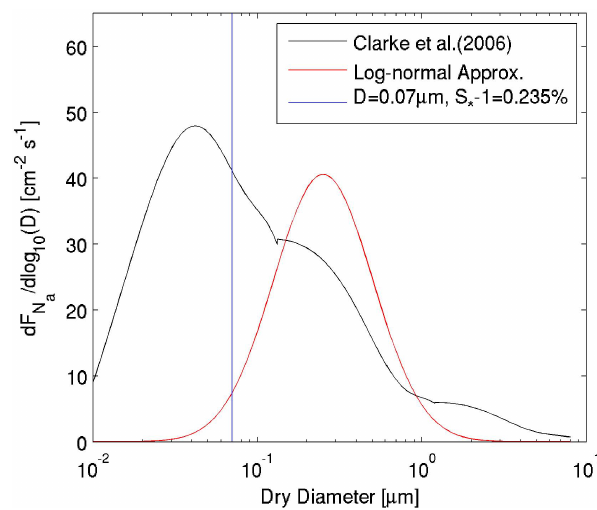
Fig. 2. Clarke et al. (2006) size-resolved sea-salt aerosol number flux and unimodal CCN approximation used in this study, plotted for u 10 of 9ms − 1 . Blue vertical line indicates cutoff for viable CCN at 0.07µm. All aerosol particles in this study are assumed to have the properties of ammonium